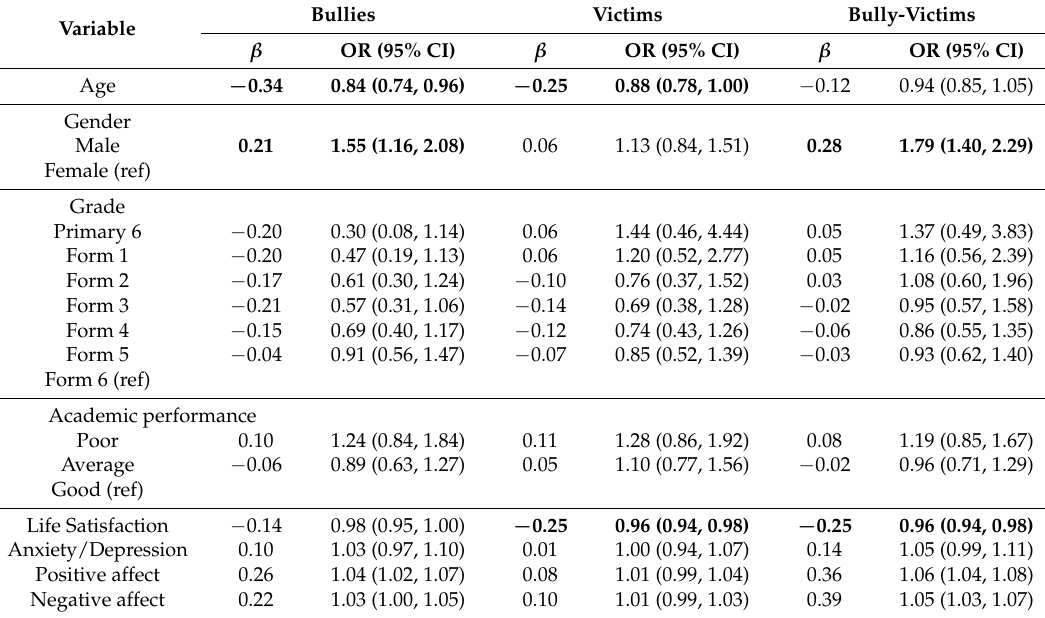
Table 4. Results of the multinomial logistic regression